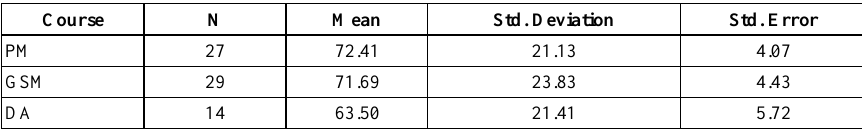
Table 1. Descriptive statistics of student